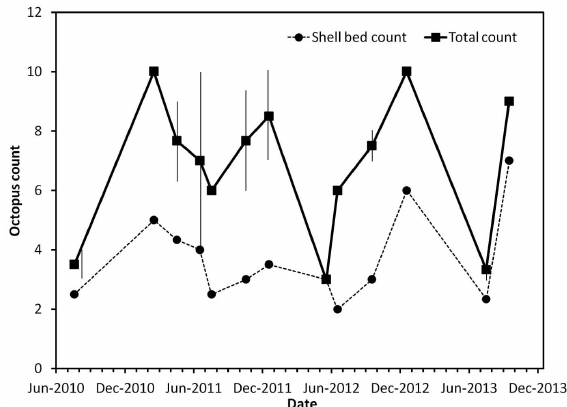
Fig. 4. – The one-metre running average of the depth to which a metal probe could be inserted into the substrate measured at 0.2-m intervals along a 20-m transect crossing the midden shell bed. The central artifact was at metre-mark 9.4, and the visible perimeters of the shell bed were detectable as a greatly increased depth to which the probe could be inserted into soft sediments on either side.